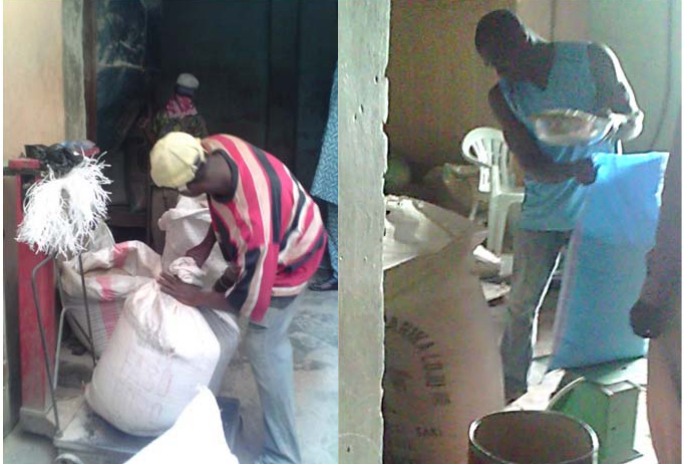
Figure 6. Weighing operation; flowering method of bag close up (left), weighing feeds